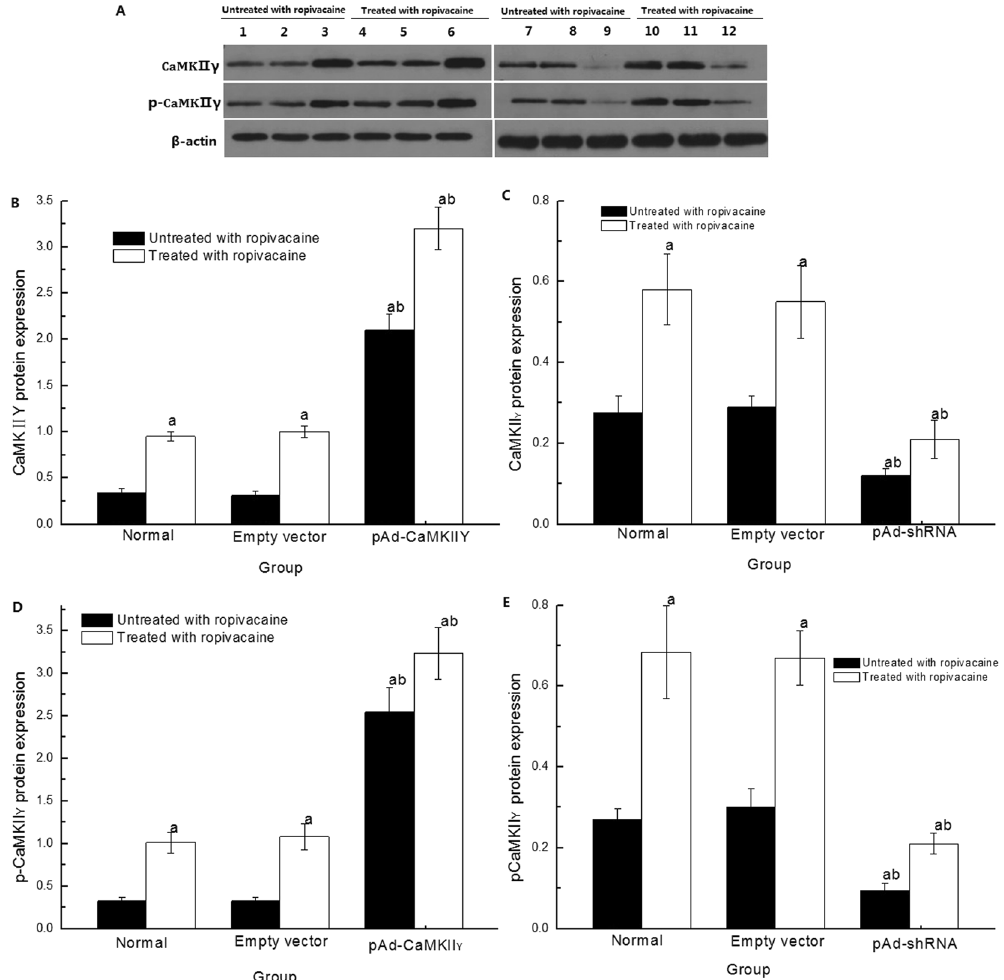
Figure 6. CaMKII γ and p-CaMKII γ protein expression detected with Western blotting. ( A ) Representative bands for CaMKII γ and p-CaMKII γ protein expression. Lanes 1 and7: Normal group; Lanes 2 and 8: Empty vector group; Lane 3: pAd-CaMKII γ group; Lanes 4 and 10: Normal + R group; Lanes 5 and 11: Empty vector + R group; Lane 6: pAd-CaMKII γ + R group; Lane 9: pAd-shRNA group; Lane 12: pAd-shRNA + R group. ( B – E ) CaMKII γ and p-CaMKII γ protein expression statistic data. ( x ± s, n = 6). a P < 0.05 vs. Normal group; b P < 0.05 vs. Normal + R